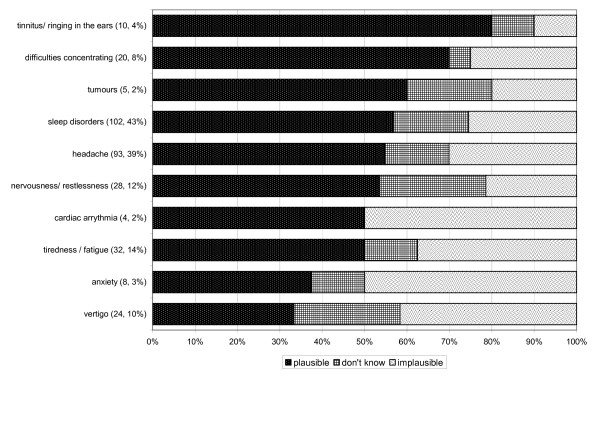
Plausibility rating of association between symptoms and their suspected source, by symptom (absolute number as well as percentage of cases who reported the respective symptom in brackets).